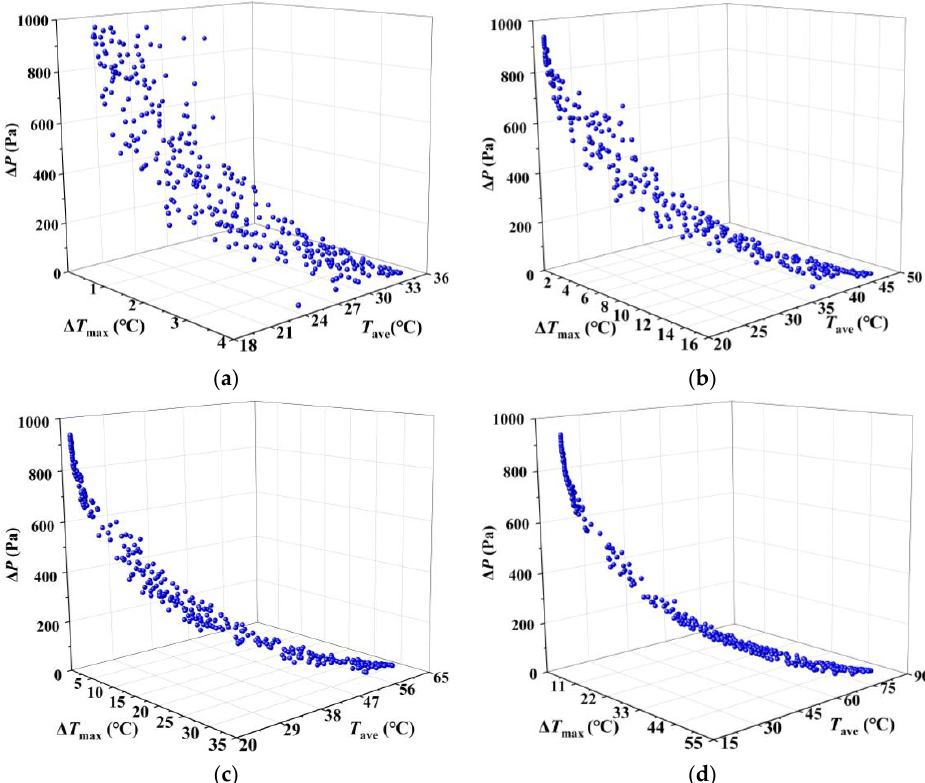
Figure 13. The Pareto solutions for average temperature and pressure drop under different dis-